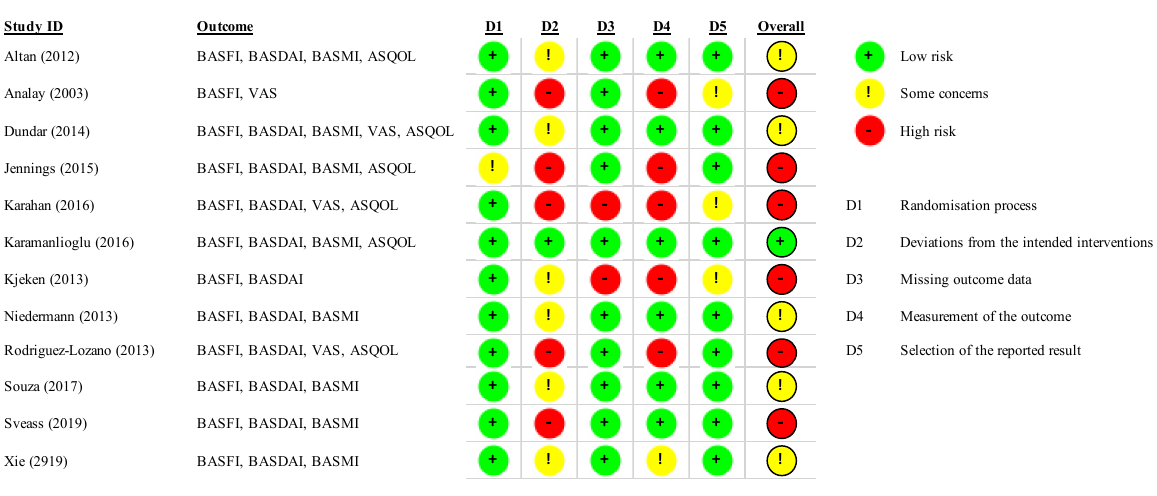
Figure 2. Risk of bias.